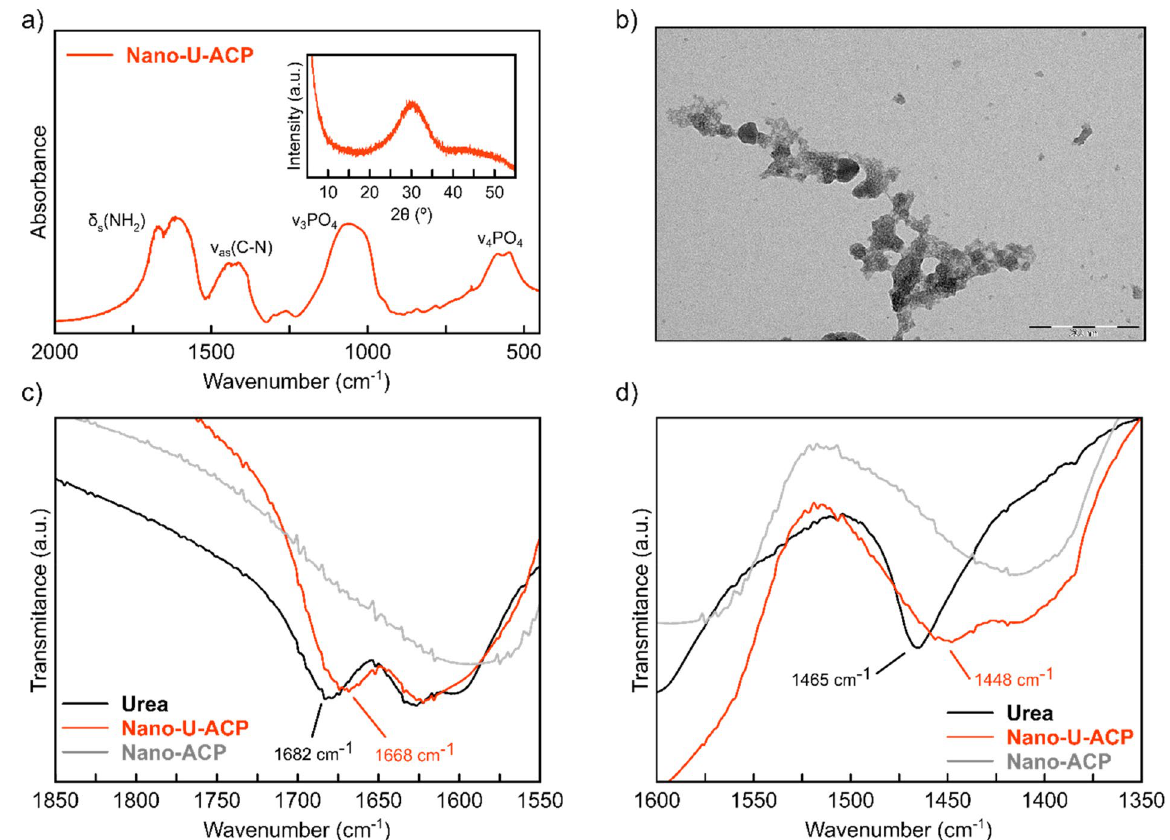
Figure 3. ( a ) FTIR analysis of Nano-U-ACP showing the typical spectrum of ACP as well as the characteristics bands of urea. Inset: X-Ray Powder diffractogram of Nano-U-ACP confirming its pure amorphous nature, ( b ) TEM-image showing Nano-U-ACP NP aggregates with irregular morphology (scale bar = 200 nm). Tiny individual dots with sizes below 10 nm (in line with SAXS results), are also imaged in the rightmost portion; ( c ) and ( d ) FTIR spectra of Urea (black curve), Nano-U-ACP (red curve) and non-functionalized ACP (Nano- ACP, grey curve) in the regions of wavenumber from 1850–1550 cm −1 and 1600–1350 cm −1 , respectively.